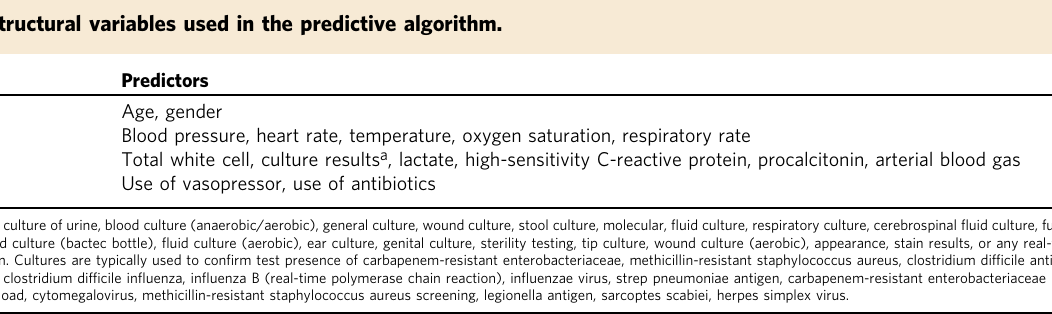
Table 1. By applying the NLP LDA model to the clinical notes dataset, we identi fi ed 100 common text topics that are in turn classi fi ed under one of the following seven categories: (1) clinical status, (2) communication, (3) laboratory tests, (4) non-clinical status, (5) social relationships, (6) symptom, and (7) treatment.